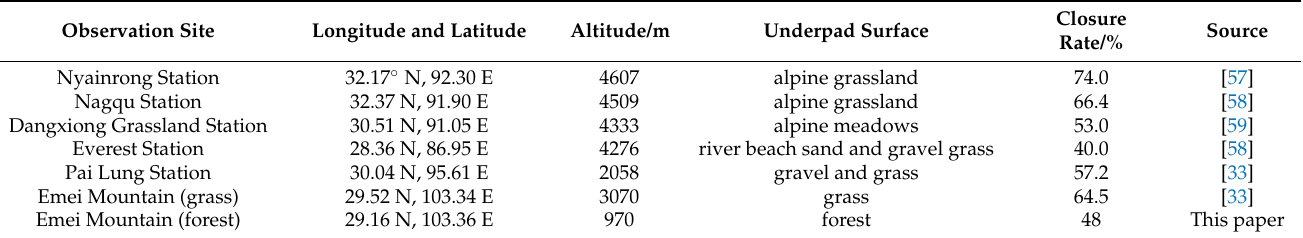
Table 4. Energy closure rate between some stations in Qinghai-Tibet Plateau and Mount Emei